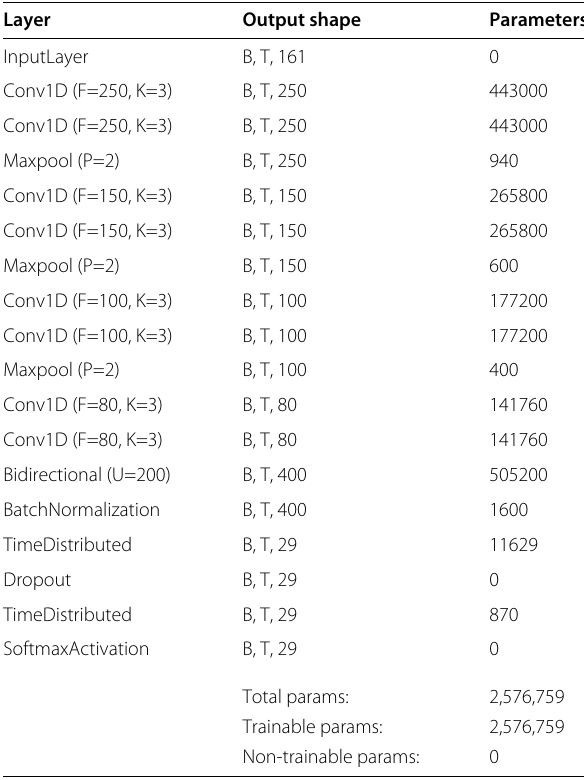
Table 3 Detailed architecture of the CNN-RNN model used as the ASR